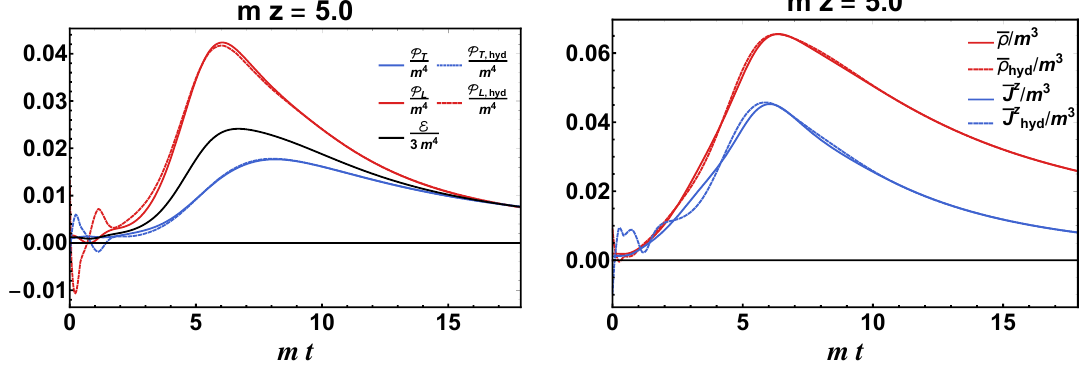
Figure 9 . Comparison of P L , P T , the lab frame baryon number density (cid:26) (cid:17) J t and current J z for thick sheets extracted directly from simulation versus the values obtained via the hydrodynamic constitutive relations. The calculation is done with (cid:15) = 0, (cid:21)